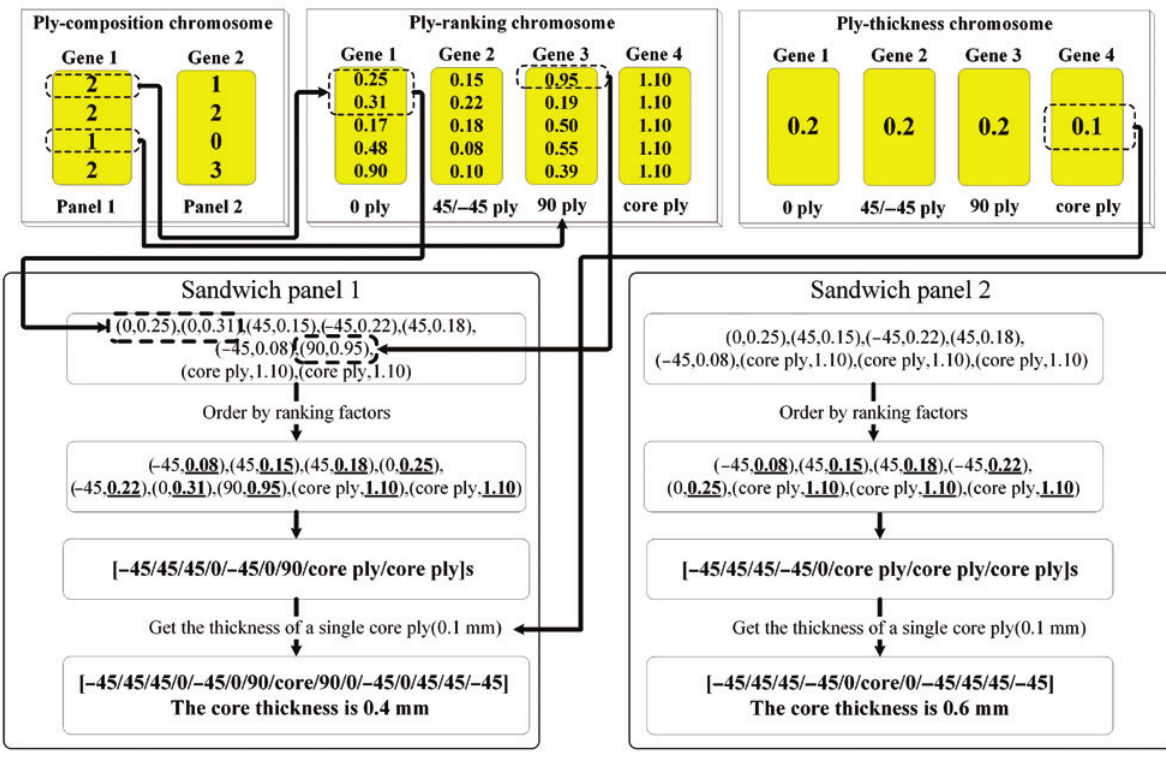
Figure 7: An example for the decoding of